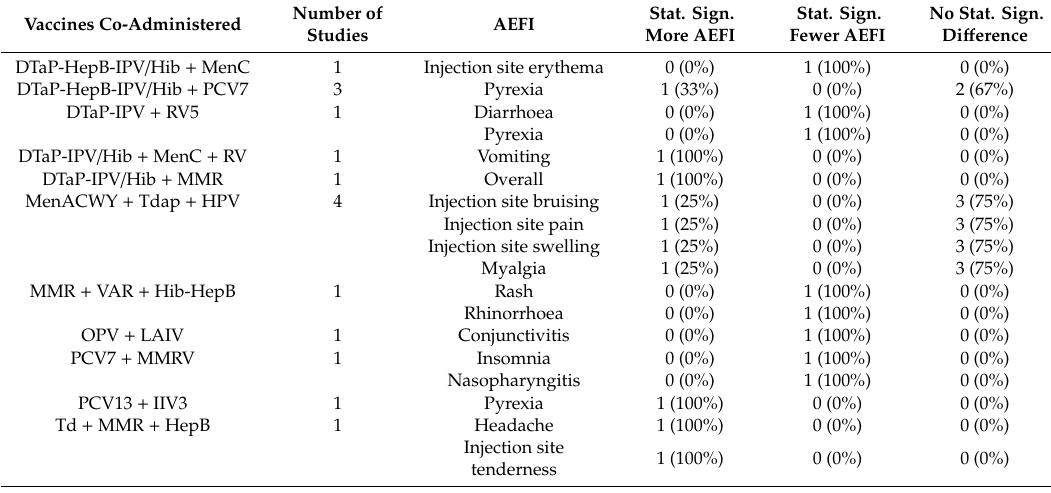
Table 2. Number of studies with statistically significant di ff erences in AEFI after co-administration compared to separate